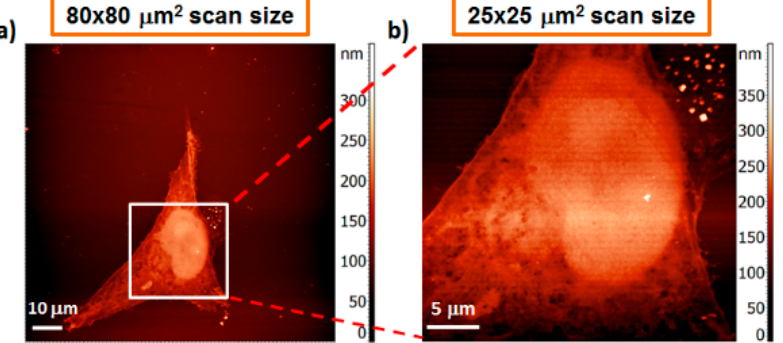
Figure 25. Soft X-ray images of fixed transitional cancer cell of the urine bladder (T24), field of view (FOV) = 80 × 80 μ m 2 and 25 × 25 μ m 2 ( a , b ). The images were acquired with exposure of 200 SXR pulses, 20 s exposure. Figure modified, based on [76].